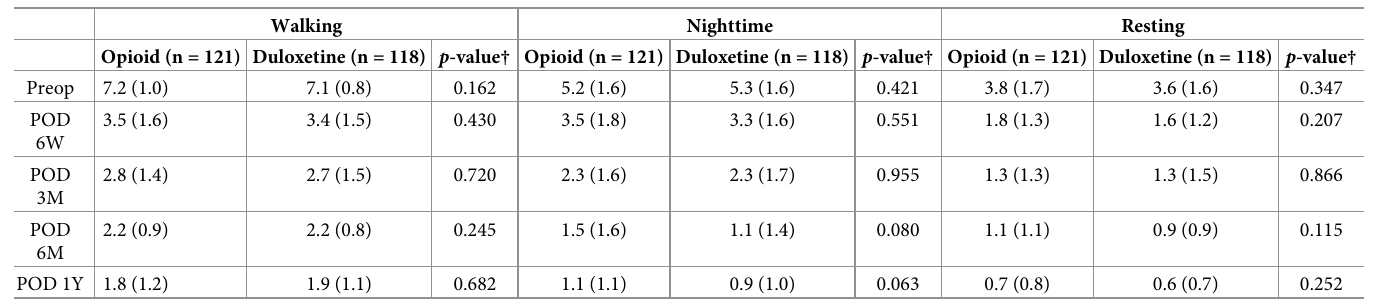
three months, six months, and one year during ambulation, at nighttime, and at rest (all p > 0.05) (Table 2). ROM did not differ between the two groups preoperatively or postopera- tively (all p > 0.05) (Fig 2). PCA consumption was 52.6 ml in the opioid group and 55.3 ml in the duloxetine group without showing significant difference ( p = 0.492). When the use of PCA was compared based on BMI 24 [2], it showed no significant difference between the group with BMI > 24 and the group with BMI � 24 in either opioid or duloxetine users (all p > 0.05). WOMAC pain score did not differ between the two groups either (all p > 0.05). WOMAC Stiffness, Function, and Total score showed no significant difference between the two groups either at each time point (all p > 0.05) (Fig 3). The 30-day readmission rate was similar between the two groups (duloxetine group vs. opi- oid group: 3 (2.5%) vs. 1 (0.8%), p > 0.05). Two patients in the duloxetine group and one patient in the opioid group were readmitted for pain control. The one patient in the duloxetine group was due to superficial wound infection.